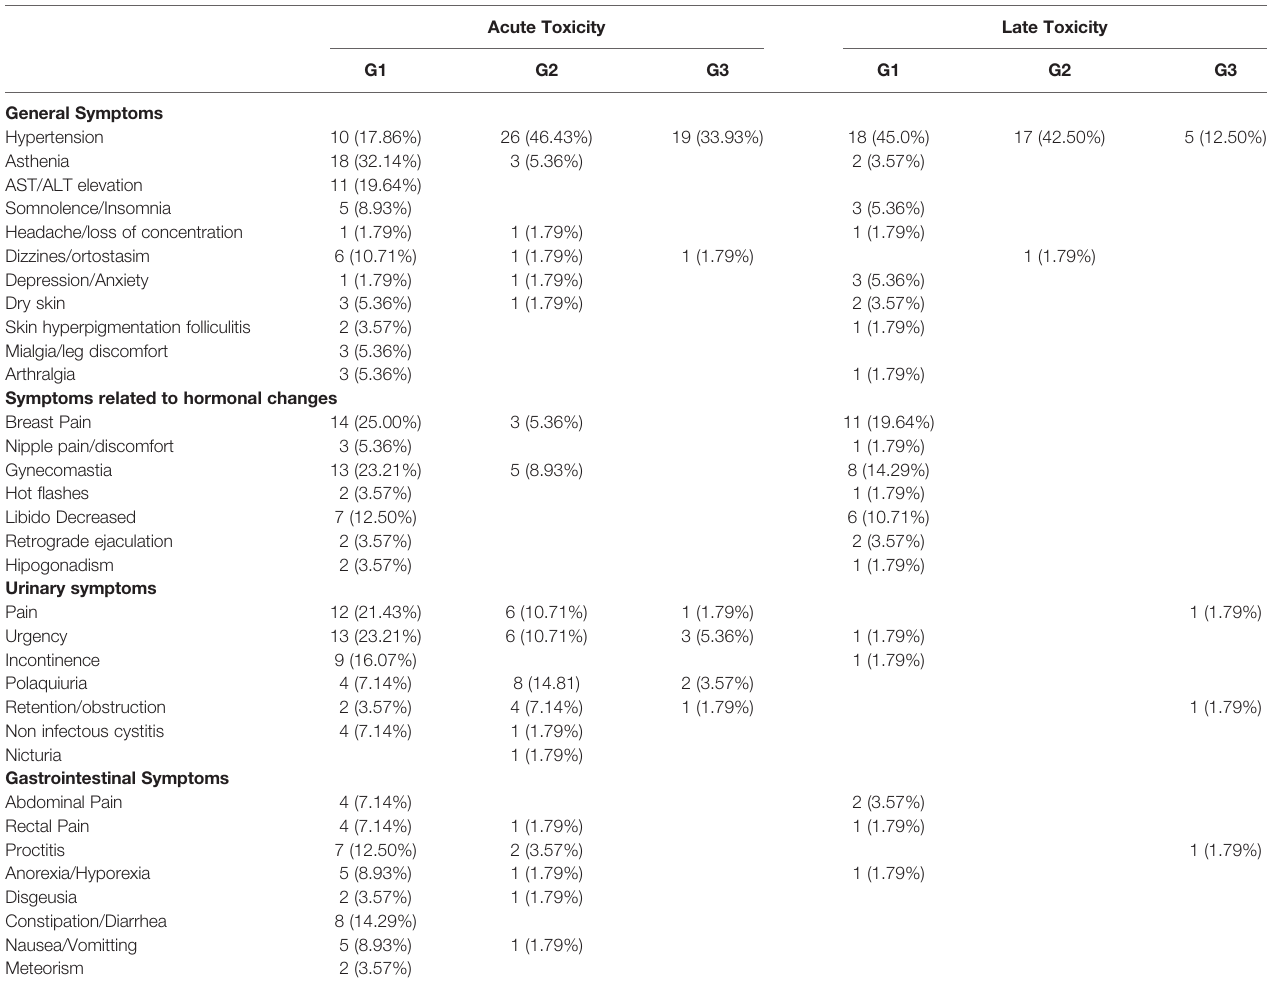
TABLE 2 | Maximum grade acute and late adverse effect after treatment in 56 evaluable